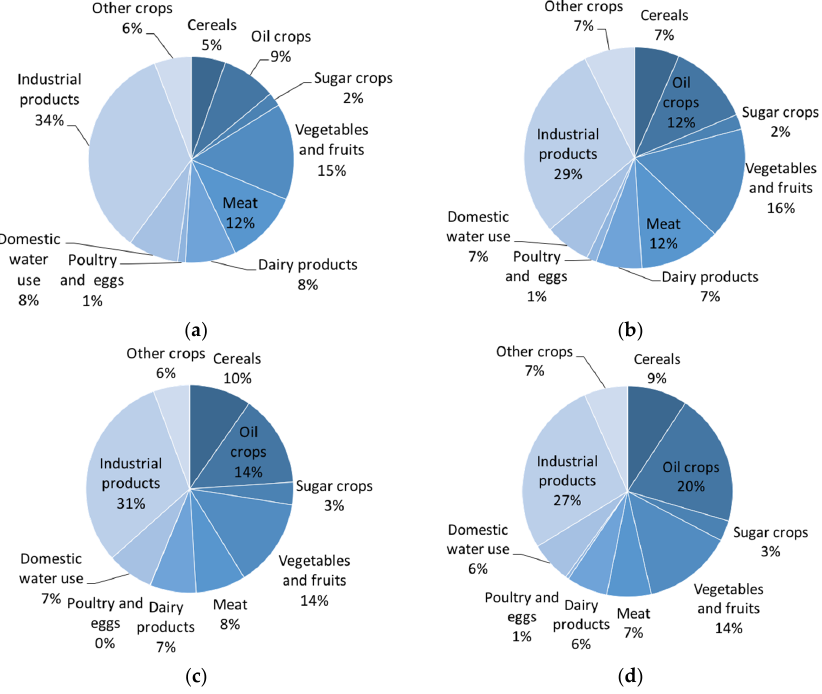
Figure 10. The composition of the blue water footprint (WF) of European consumption by commodity in scenarios ( a ) S1, ( b ) S2, ( c ) S3 and ( d ) S4.